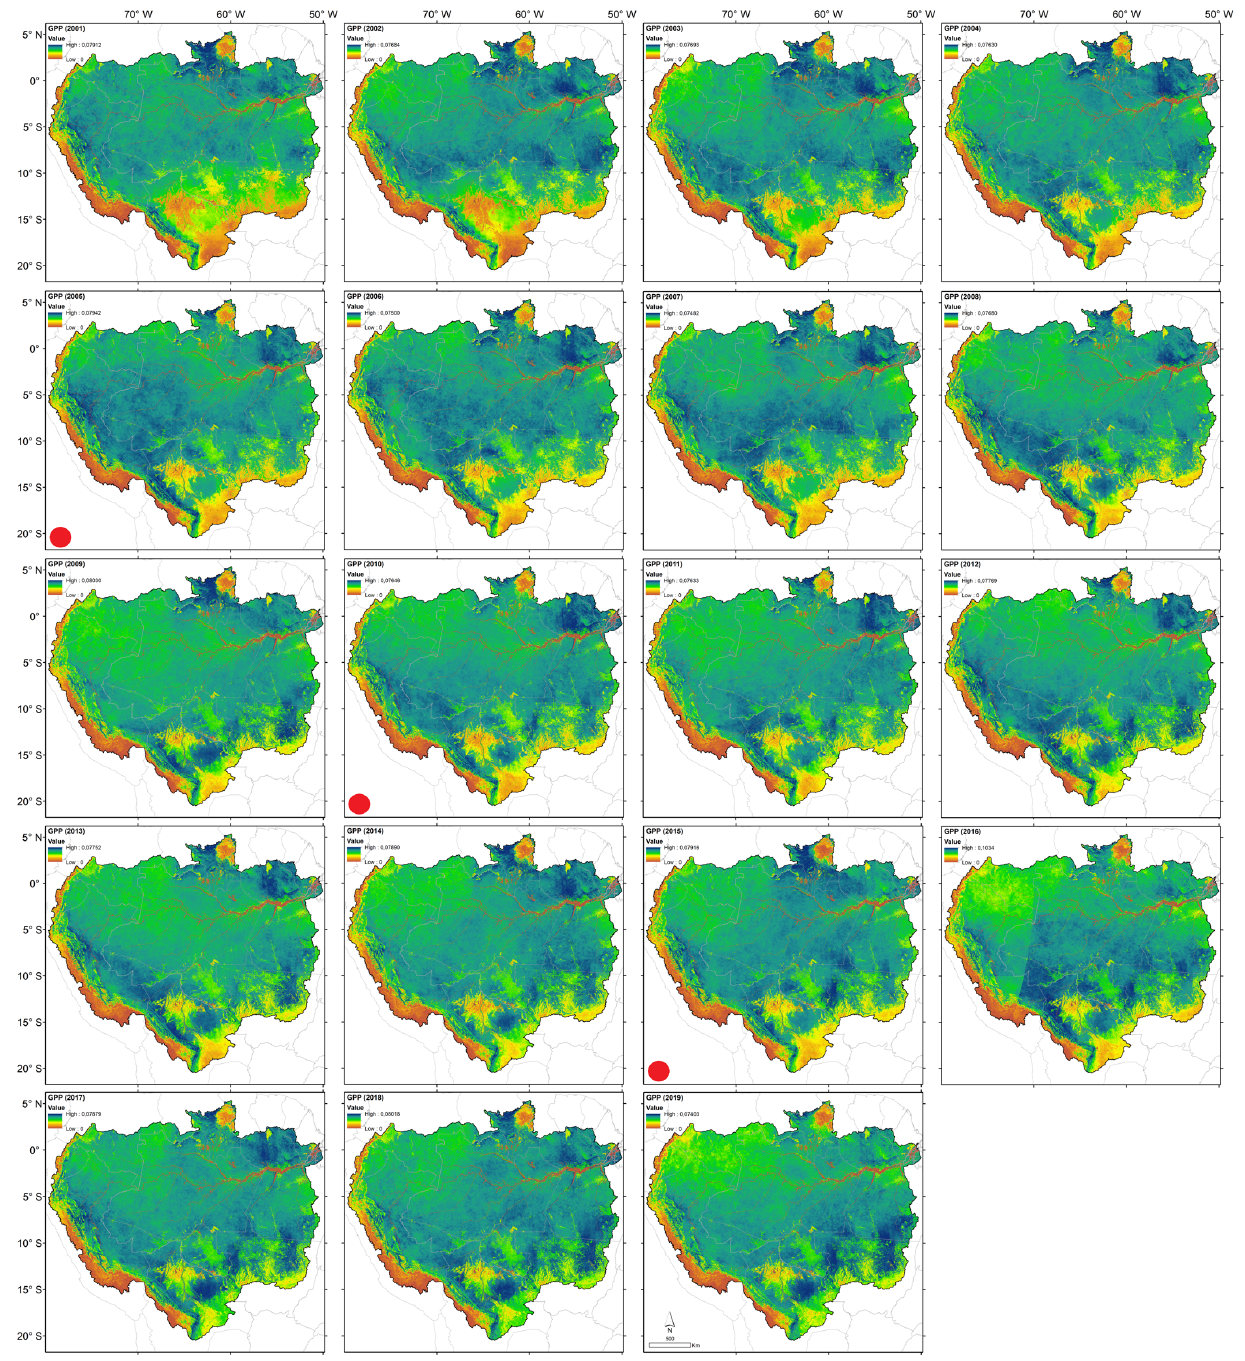
Figure 2. Measurement of each annual pixel for the gross primary productivity (GPP, kg C m − 2 year − 1 ) variable of the Amazon Basin between 2001 and 2019. Red dots indicate the occurrence of El Niño (see Figure S2). Notice that the color scales vary slightly from year to year.